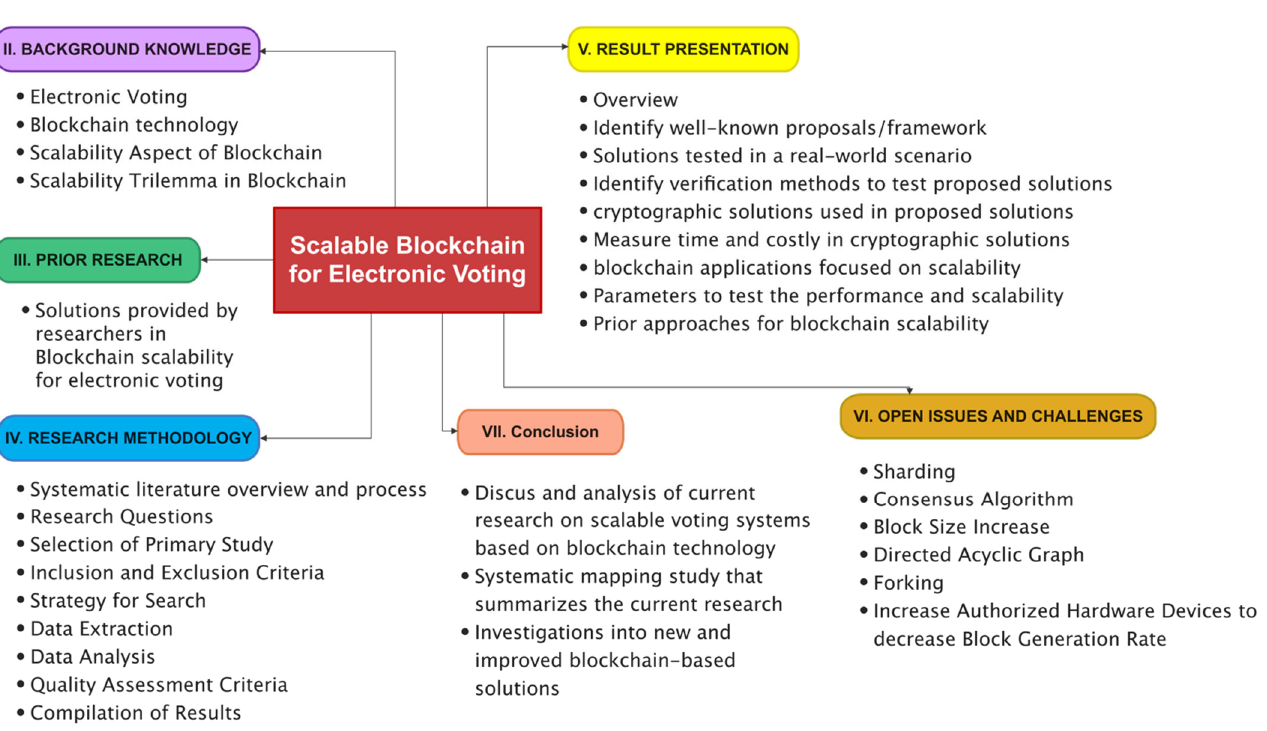
Figure 1. Road map of Blockchain ‐ based electronic voting .